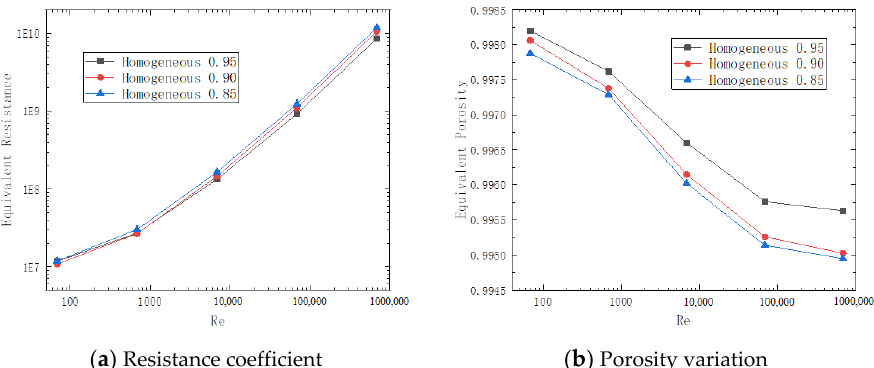
Figure 9. Variation of resistance coefficient and porosity of the porous homogenization model.